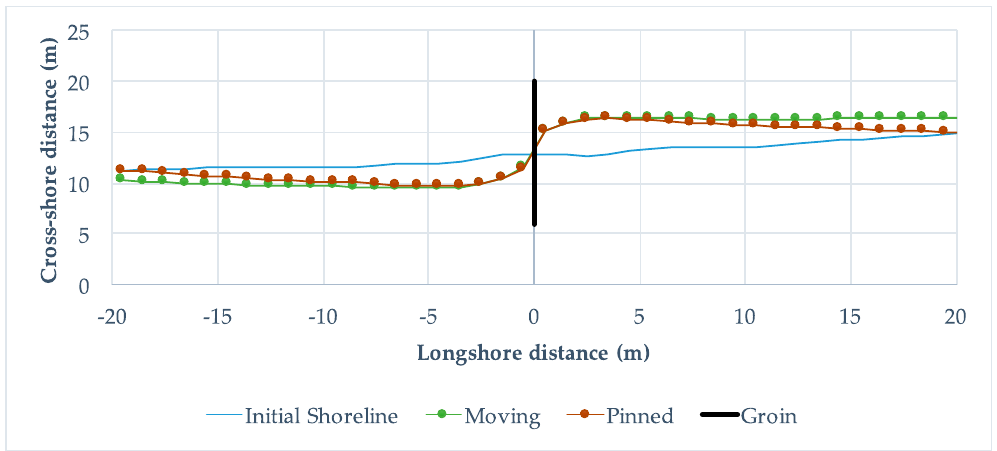
Figure 11. Comparison of the simulated shoreline positions obtained after 23 h for the two different lateral boundaries.